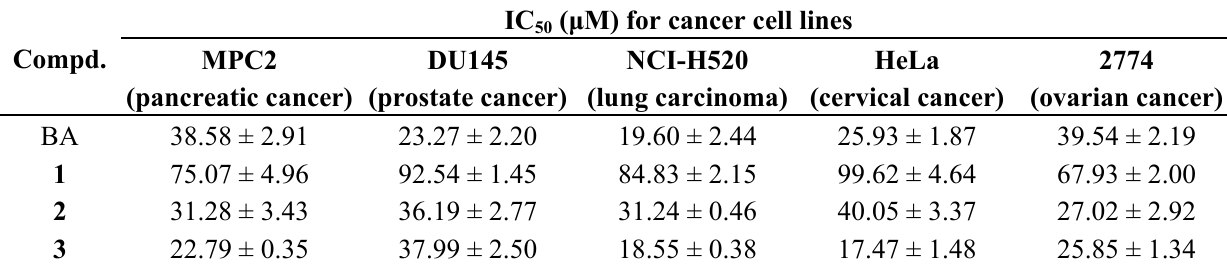
Table 3. Cytotoxicity of the compounds against a panel of human cancer cell lines.